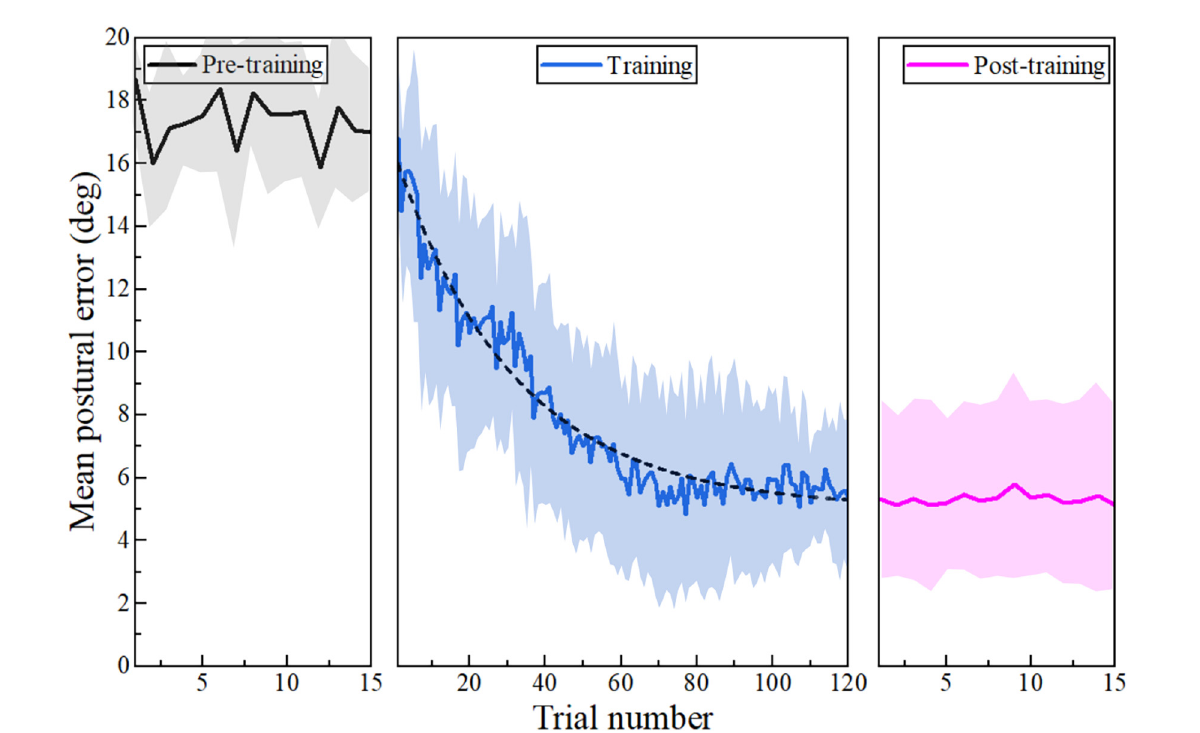
FIGURE2 Postural error: Postural error is shown for pre-training (solid black line), training (blue line), and post-training (pink line) phases for each trial. The shaded region around the mean line represents the standard deviation of the postural error. Haptic feedback is enabled during the training phase based on the task difficulty determined by the adaptive algorithm. As a result, postural error decays exponentially during the training phase (dotted black line) compared to the pre-training phase. A decrease in postural error is maintained during the post-training phase after the removal of haptic